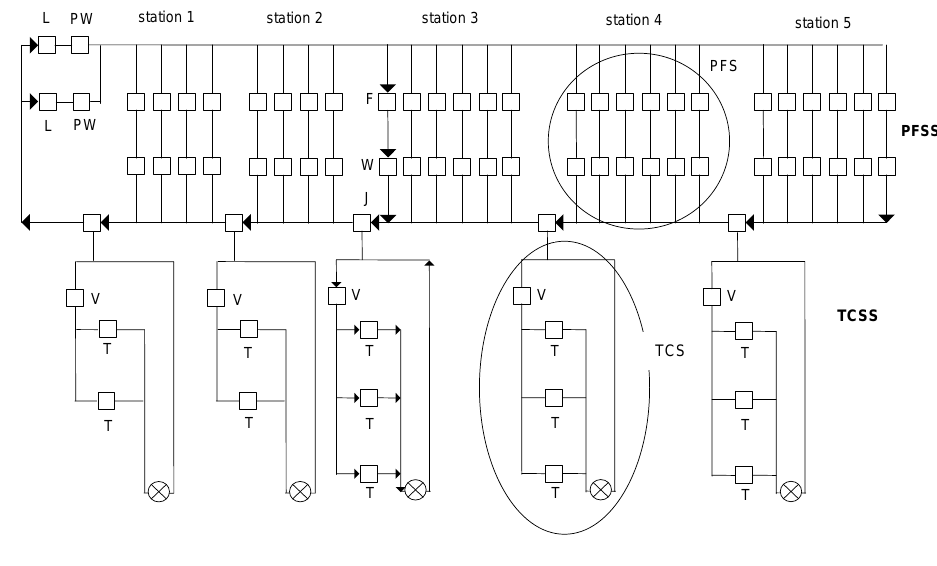
Figure 3. “Current layout (CL)”. Source: Jeong and Hong